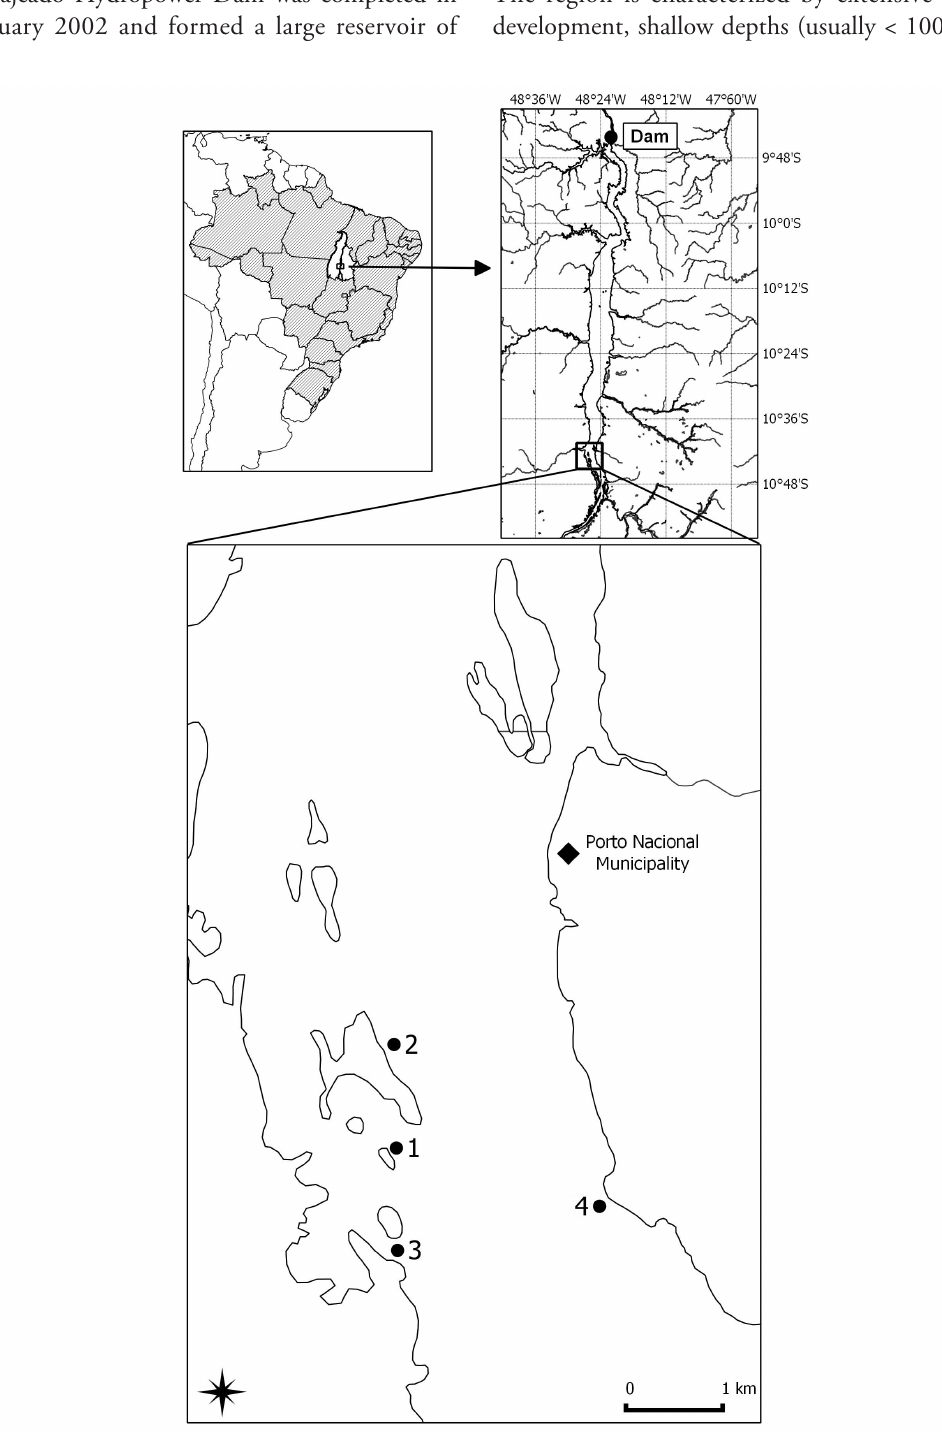
Figure 1. Distribution of sampled sites (1-4) in the upper portion of Lajeado Reservoir, Tocantins River,